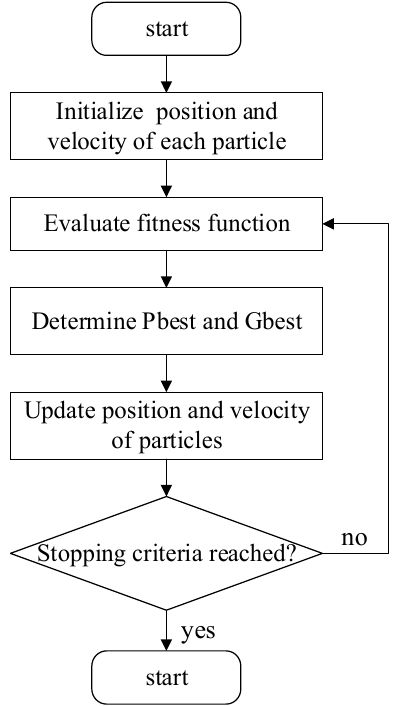
Figure 5. The flow chart based on the PSO